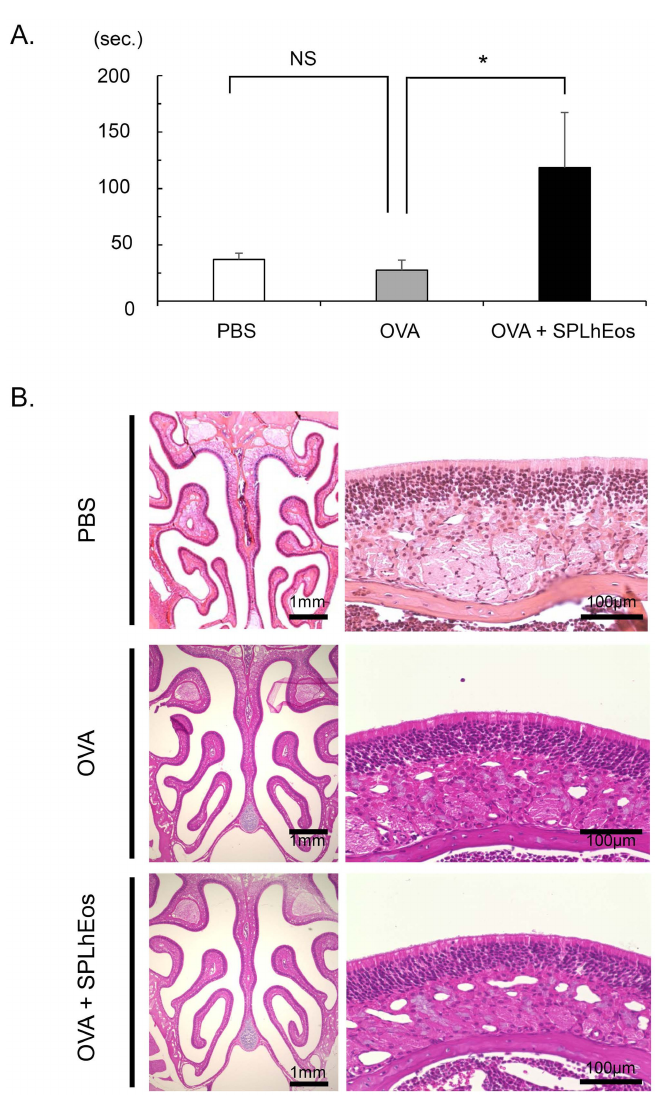
Figure 2. Buried food test ( A ) and histological analysis ( B ) following the transfer of SPLhEos in Th2-skewed response. ( A .) Open, gray, and black bars indicate the transfer of PBS alone, OVA alone, and OVA + SPLhEos (4 × 10 7 cells) in the adoptive transfer system, respectively. Data are expressed as means ± SEM of n = 5 mice per group. * Statistically significant difference from control mice ( p < 0.05). ( B ) Hematoxylin and eosin (H&E) staining of histological